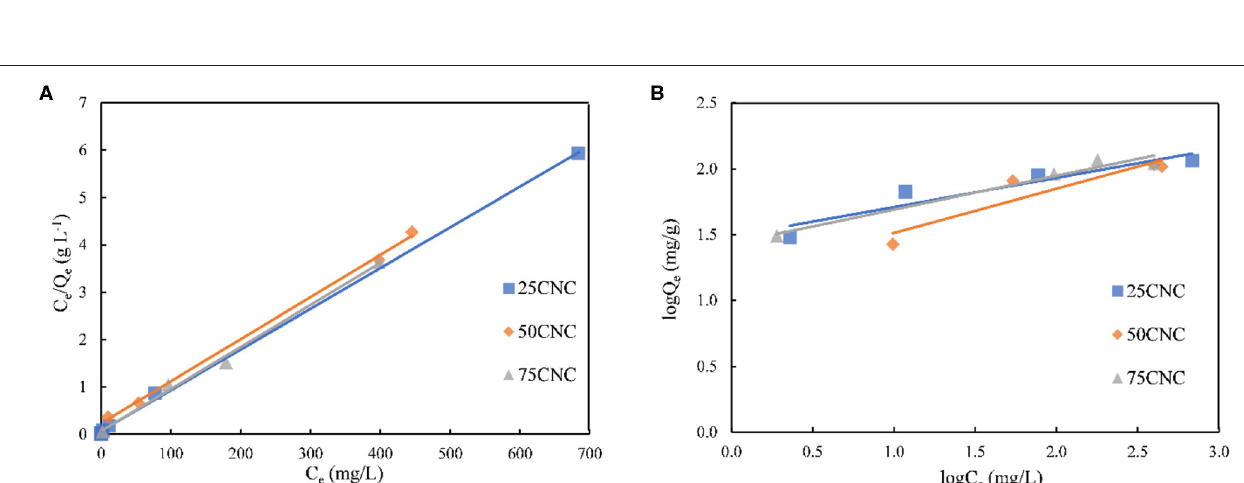
For example, the S BET values were 8.23 m 2 g − 1 for 100CNC cross-linked CNC aerogels had shown larger pore